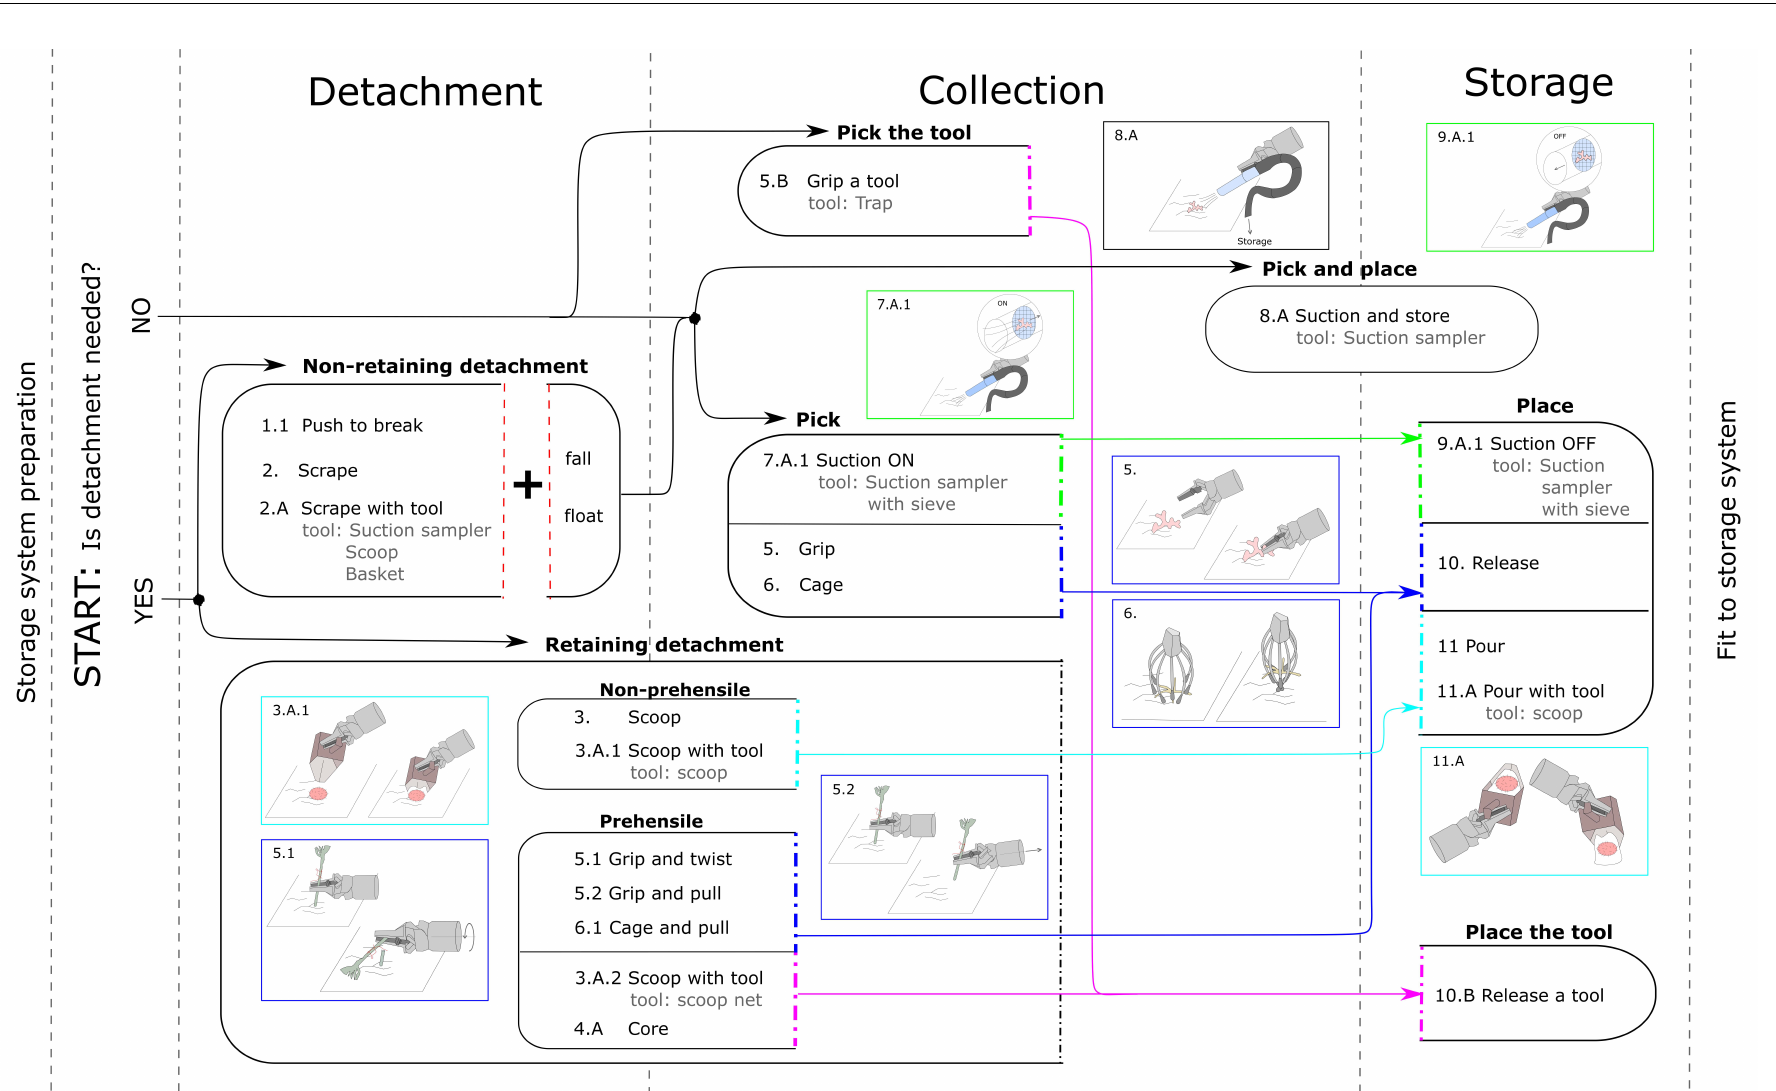
Figure 2. Taxonomy of atomic manipulations for marine sampling procedure with ROV. The arrows indicate how the atomic manipulations can be combined to build possible manipulation